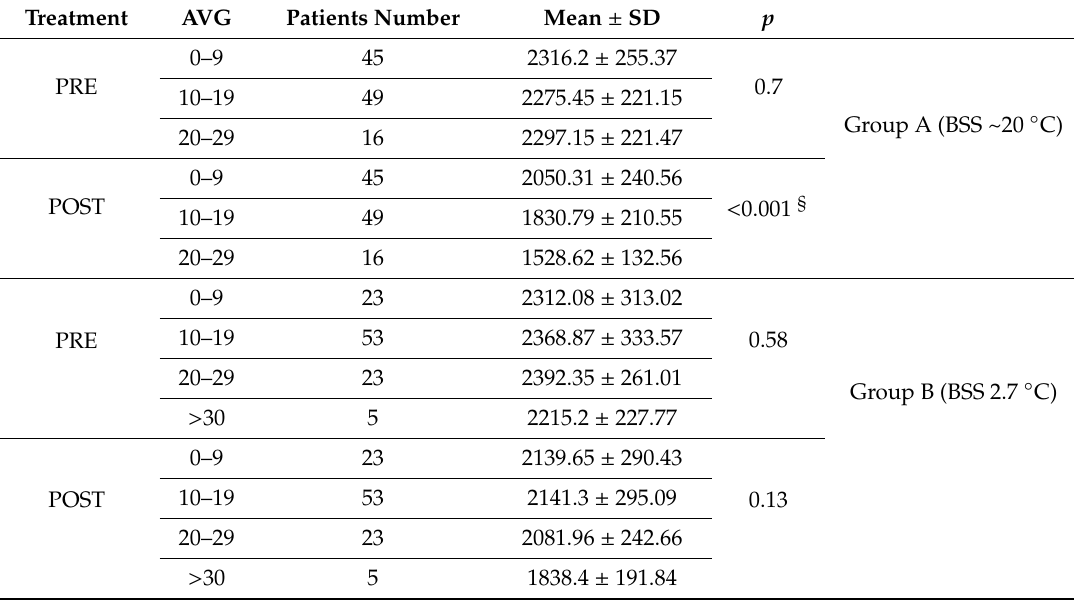
Table 6. One-way ANOVA